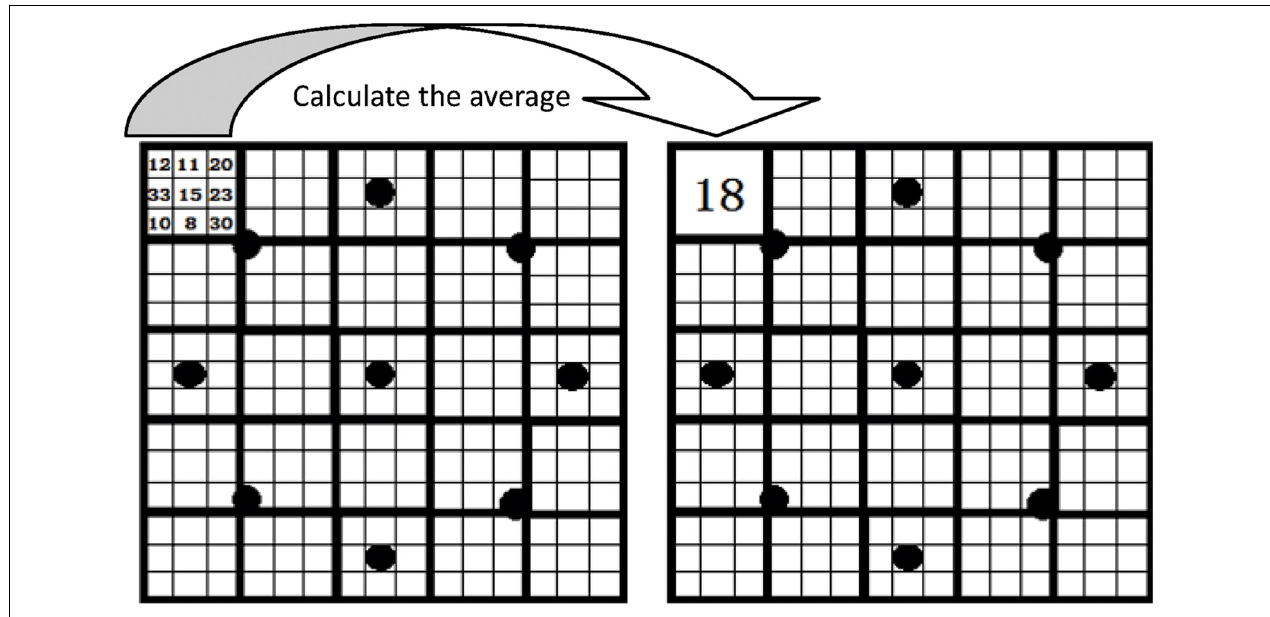
FIGURE 2 | The diagram of the MB 3 -LBP